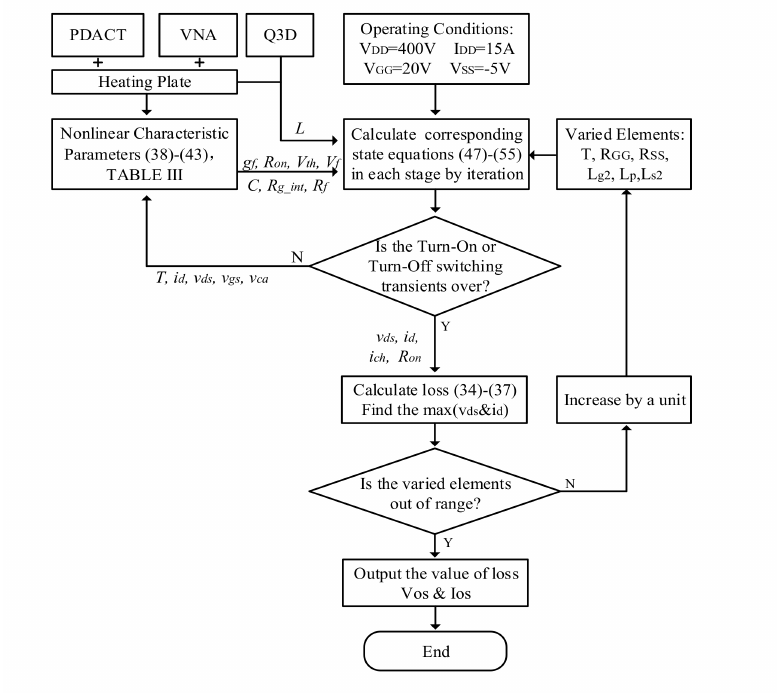
Figure 9. Flowchart for loss